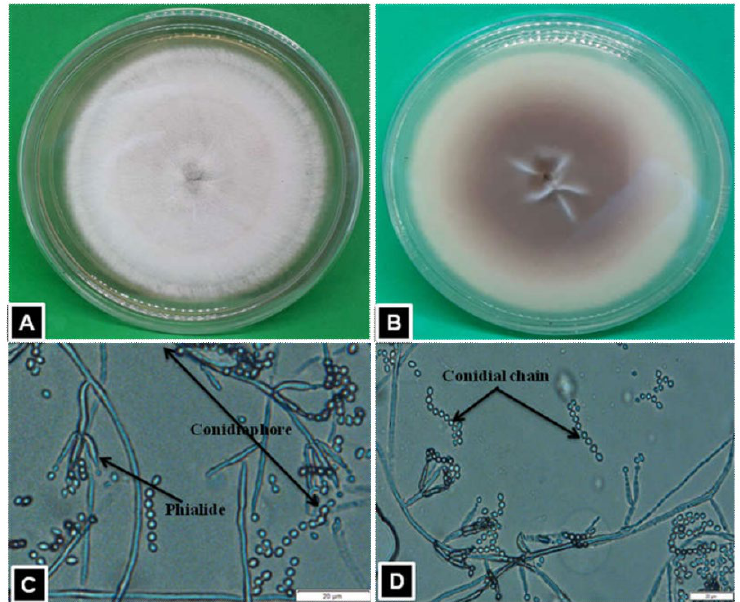
Figure 2. Morphological characteristics of representative isolate (PLTP5) of P. lilacinum : ( A ) Front colony grown in SDAY for 15 days; ( B ) Reverse colony; ( C , D ) Conidiophores with phialides and conidia observed under light microscope with 400× magnification.